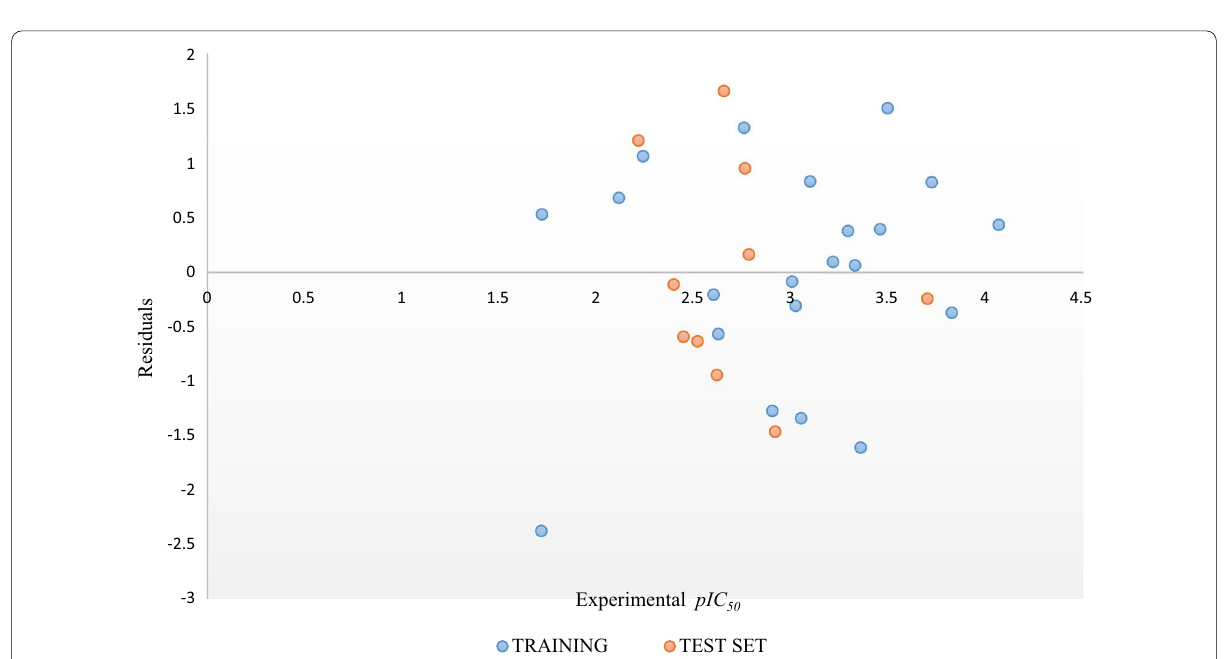
Fig. 1 XY (scatter) plot of residuals against experimental pIC 5 0 of both the training and test sets compounds